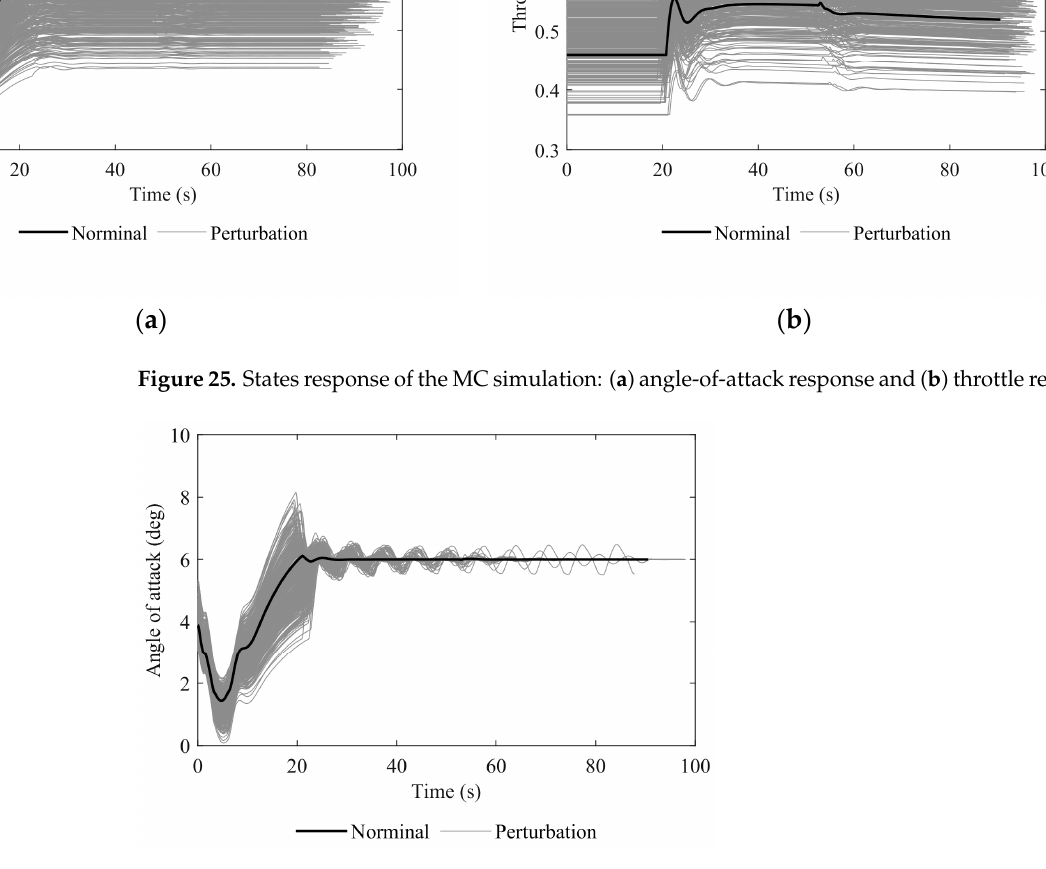
Figure 25. States response of the MC simulation: ( a ) angle-of-attack response and ( b ) throttle re- sponse.